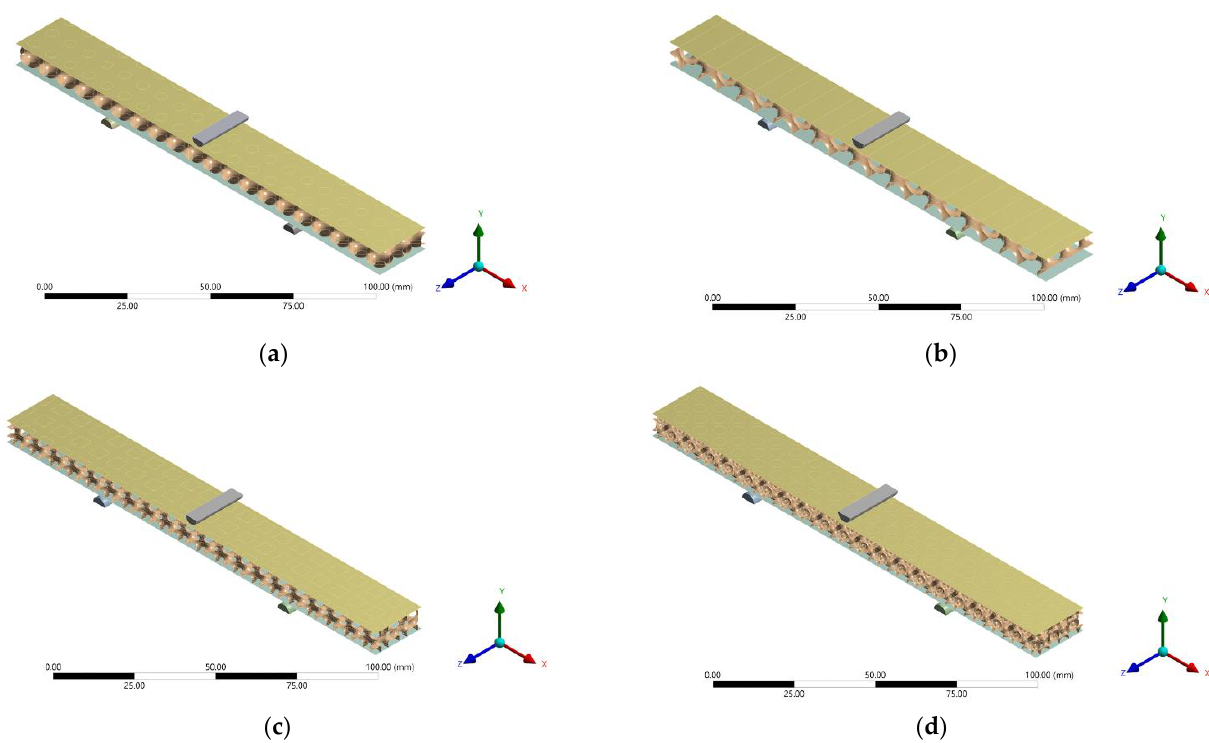
( d ) Figure 4. Patterns used to generate SPSs with different TPMS lattice cores: ( a ) SP, ( b ) S2, ( c ) I-WP and ( d ) F-RD. 3.2. Finite Element Analysis 3.2.1. Model Many studies have demonstrated that discretising the core surface as a shell rather than a solid mesh produces superior results. This is because the thickness aspect ratio is large, and the shell model can provide more accurate results [26 – 28]. To generate the shell model, the software Rhino was used to generate TPMS geometries, which were then ex-